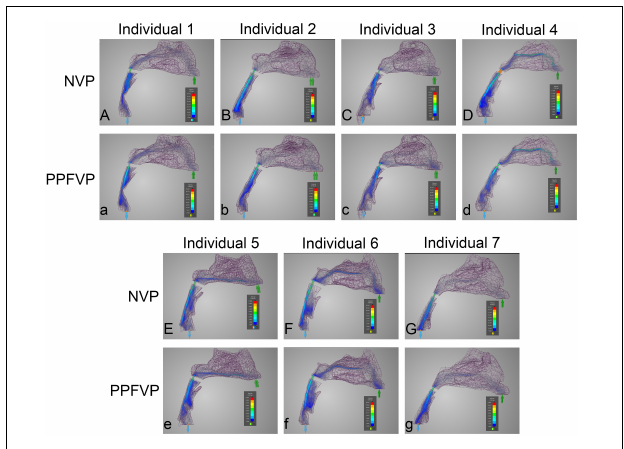
FIGURE 2 | Airflow velocity patterns through the upper airways. The airflow velocity patterns of seven individuals were demonstrated. The color of the airflow was used to show the velocity changing in the same model. NVP, normal velopharyngeal closure (one port); PPFVP, velopharyngeal closure after posterior pharyngeal flap palatoplasty (two ports). The scale bar cannot be fixed because of the real-time simulation process in which the scale bar was changing with